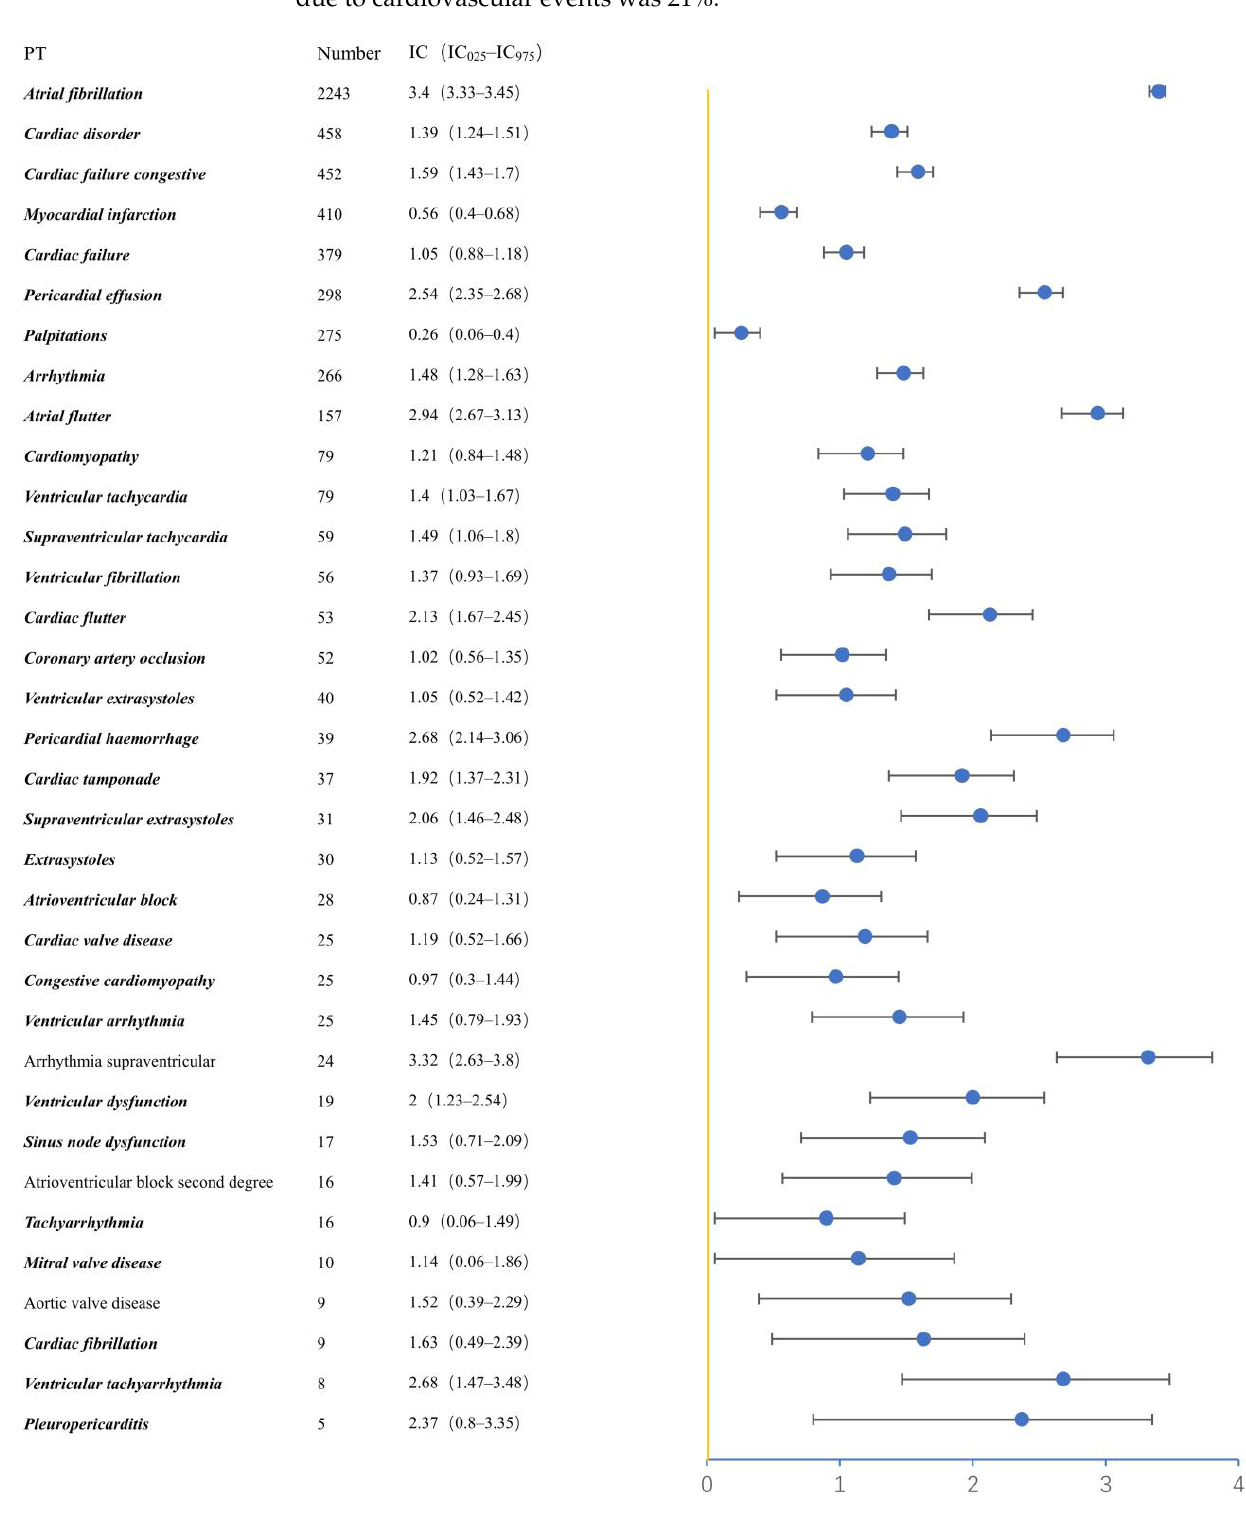
Figure 2. The signals in preferred terms (PTs) associated with cardiovascular toxicities .